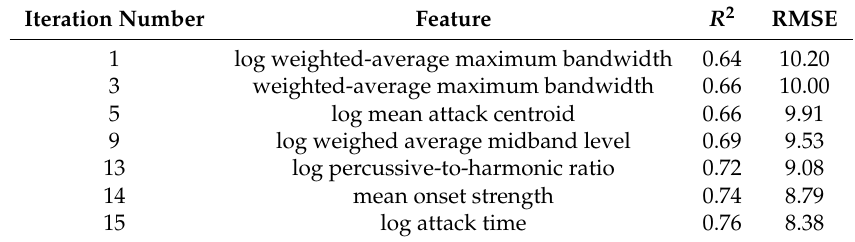
Figure 5. Performance of the multilinear regression model for each stage of the iterative modelling. The dashed grey lines represent iterations where the model shows marked improvement. Table 1. Performance of the features that show improved performance during the iterative modelling